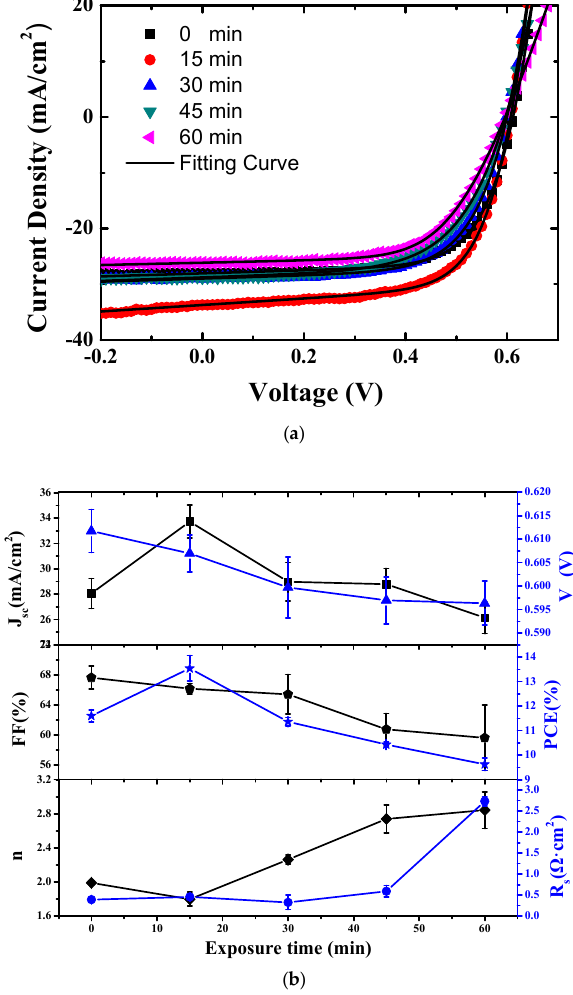
Figure 3. ( a ) J–V curves of the planar hybrid Si/PEDOT:PSS solar cells with different exposure times under 100 mW/cm 2 illumination (AM 1.5 G). ( b ) Variation of device parameters with different exposure times. Table 1. Extracted parameters of the planar hybrid Si/PEDOT:PSS solar cells at a temperature of 27 °C. Time